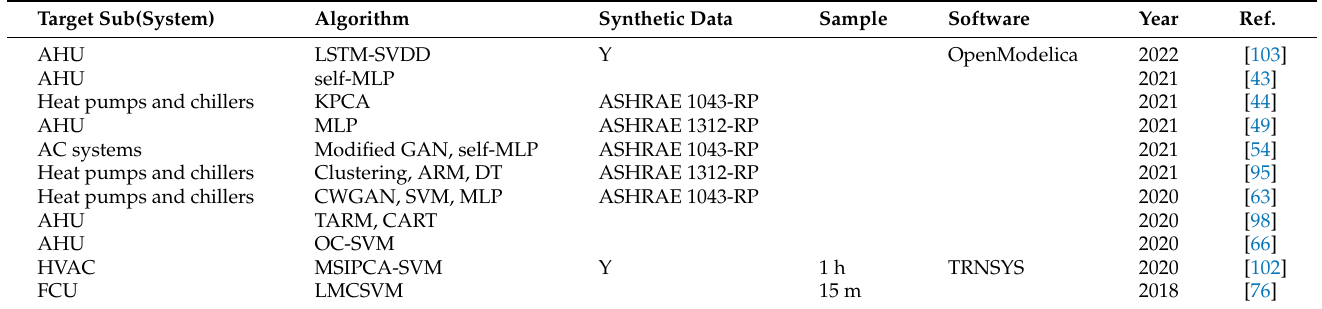
Table 6. Semi-supervised learning used in the research from the selected literature. For clarity, all acronyms are provided in the Abbreviations